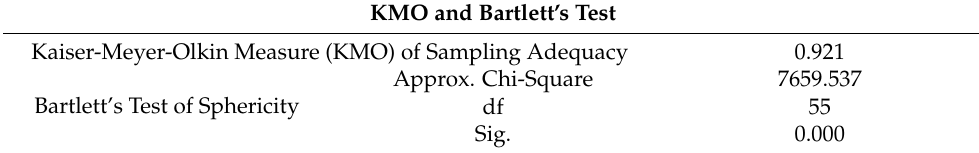
Table 1. Validity: KMO and Bartlett’s Test.